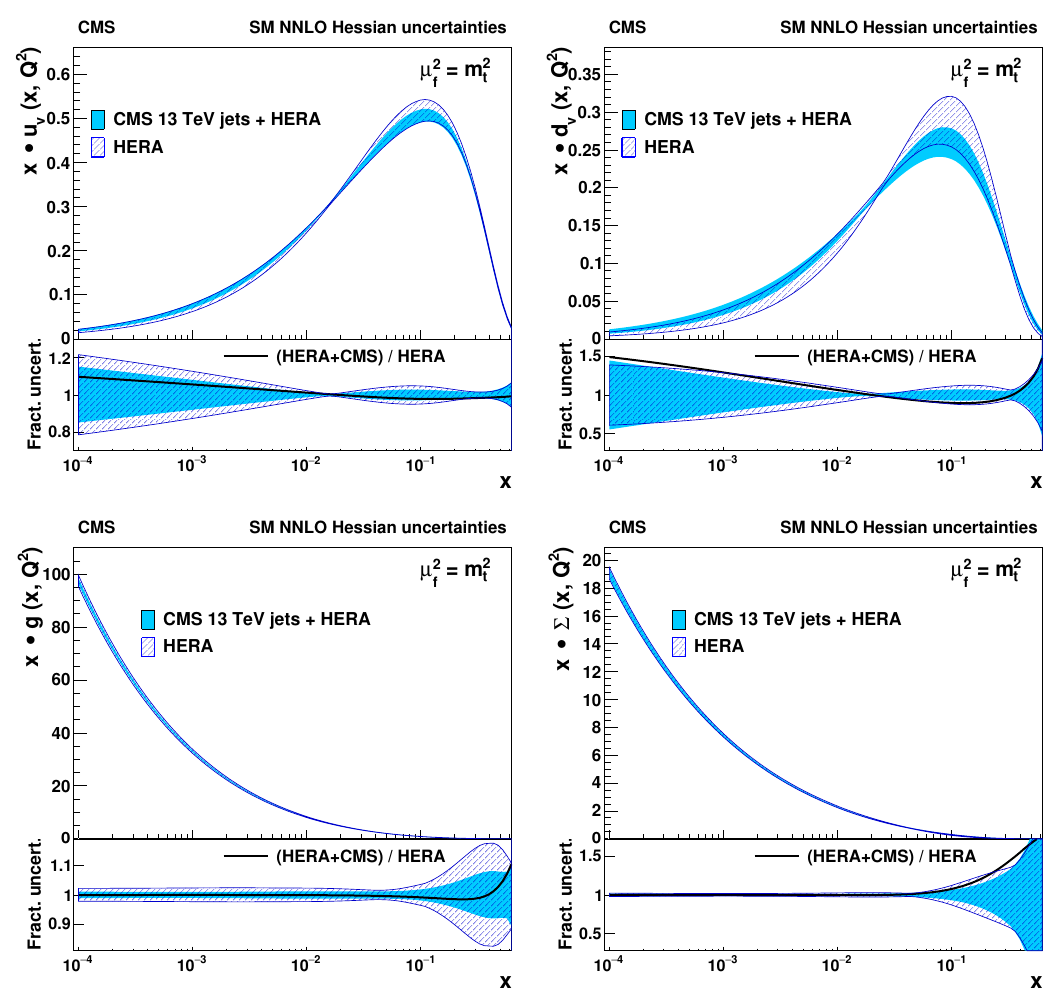
Figure 15 . The u -valence (upper left), d -valence (upper right), gluon (lower left), and sea quark (lower right) distributions, shown as a function of x at the scale µ represents the results of the NNLO fit using HERA DIS and the CMS inclusive jet cross section at √ s = 13 TeV (using the HERA DIS data only). The PDFs are shown with their total uncertainty. In the lower panels, the comparison of the relative PDF uncertainties is shown for each distribution. The dashed line corresponds to the ratio of the central PDF values of the two variants of the